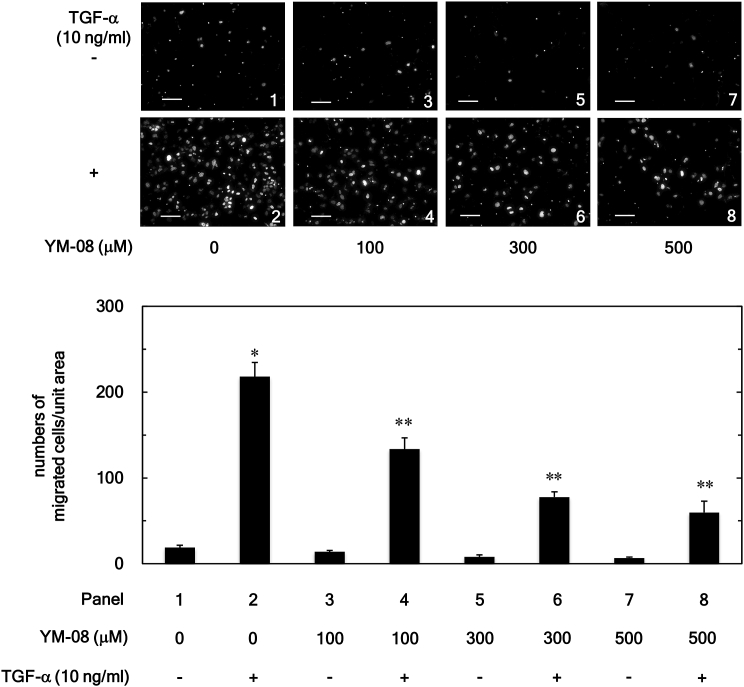
Effects of YM-08 on the TGF-α-induced HuH7 cell migration. The cells were pretreated with the indicated concentration of YM-08 for 60 min and then stimulated by TGF-α (10 ng/ml) or vehicle for 23 h. The migrated cells were stained with DAPI for the nucleus and then photographed by fluorescent microscopy at a magnification of 20× (upper panel) and counted (bar graph). Each value represents the mean ± SD of triplicate determinations. ∗p < 0.05, versus column 1; ∗∗p < 0.05, versus column 2. Scale bar: 100 μm.